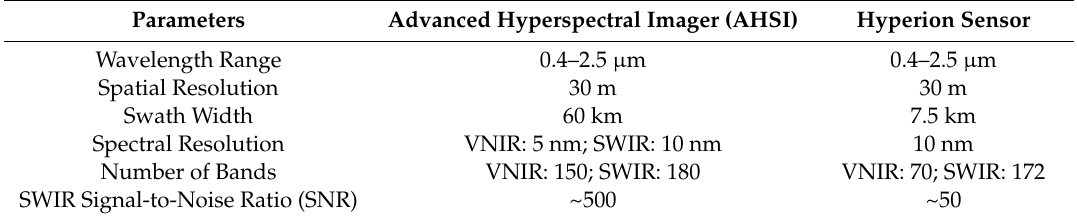
Table 3. Technical indexes of the Shortwave Infrared Airborne Spectrographic Imager (SASI).